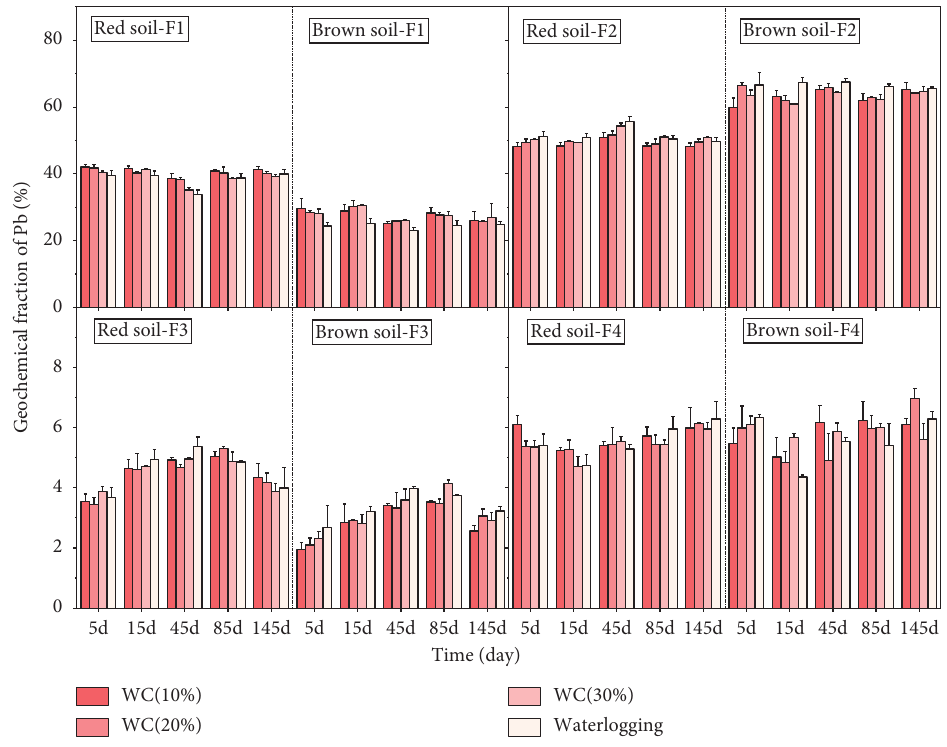
Figure 7: Changes of Pb fractions in different soil water contents as a function of contact